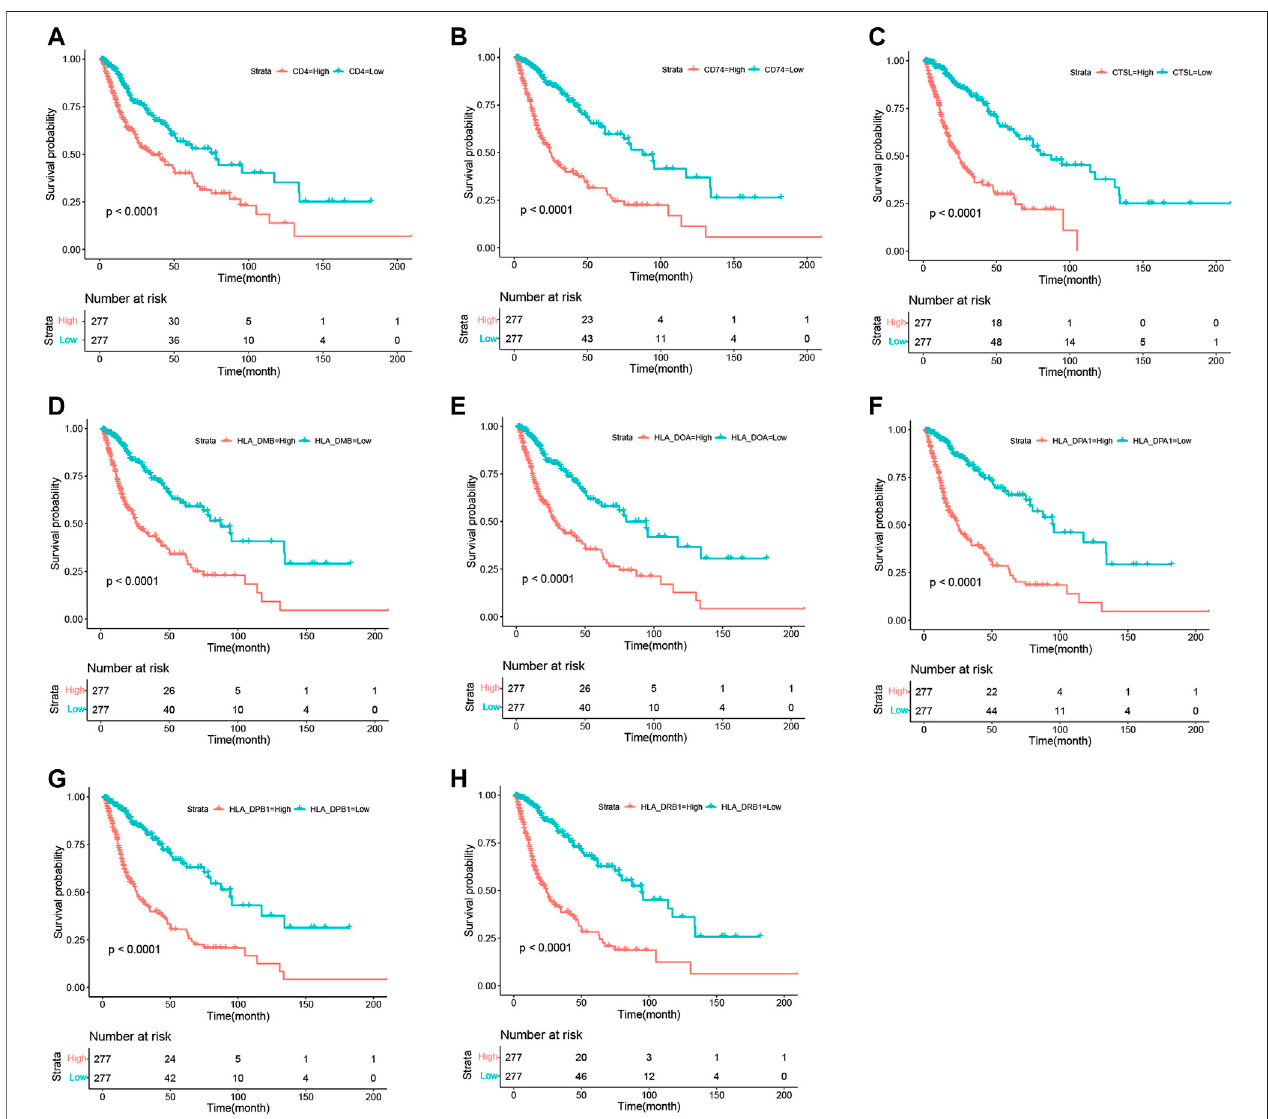
FIGURE 8 | Kaplan – Meier survival curves in glioma patients in TCGA show that the expression levels of target genes predicted prognosis. High expression: SDC1 levels in the upper median; Low expression: SDC1 levels in the bottom median.